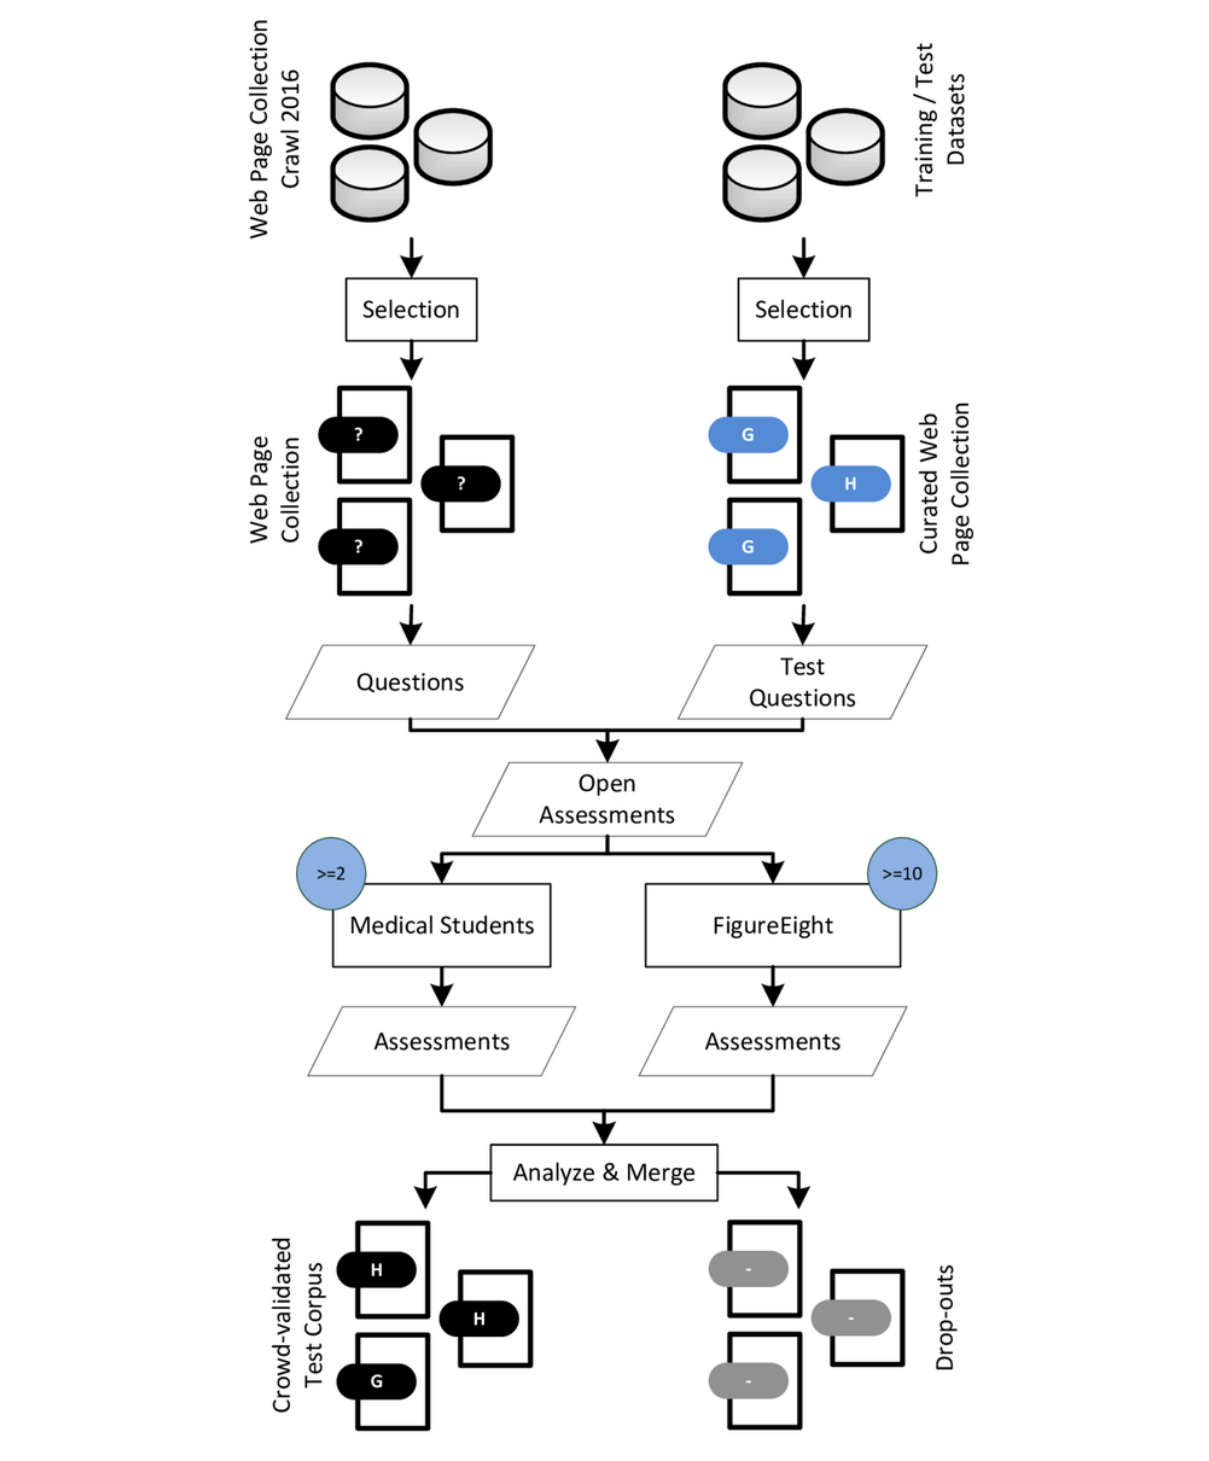
Figure 6. Workflow of the crowd-sourcing approach to build a test corpus for the purpose of classifier evaluation. Black lines indicate the assessment process; slanted boxes represent data; rectangular boxes represent processing